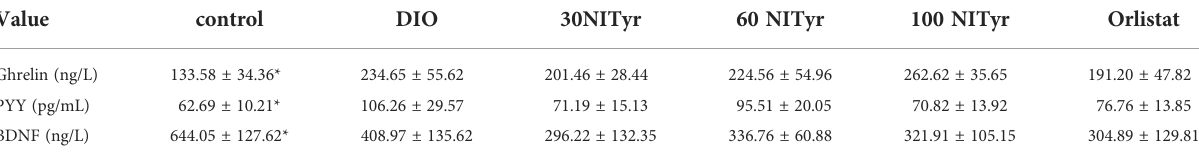
TABLE 1 Analysis of several appetite indexes in serum of mice after drug administration for 4